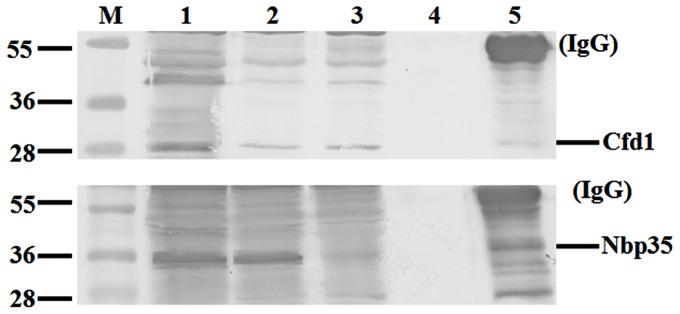
In-vivo interaction study Nbp35 and Cfd1 by immunoprecipitation.The anti-Nbp35 antibody bound with protein-A sepharose was incubated with amoebic lysate and immunoprecipitate was analysed by immunoblots were developed separately with anti-Cfd1 (upper panel) and anti-Nbp35 (lower panel) antibodies. IgG heavy chain (55 kda) and Cfd1 (29 Kda) were found in I.P. complex fraction and IgG heavy chain (55 kda) and Nbp35 (35 kda) bands found when probed with anti-Nbp35 antibody. Lane M- represents molecular weight proteins marker, lane 1- total amoebic lysate, lane 2- supernatant of amoebic lysate, lane 3- amoebic lysate flow through, lane 4- final wash did not show any proteins, lane 5- I.P. complex.